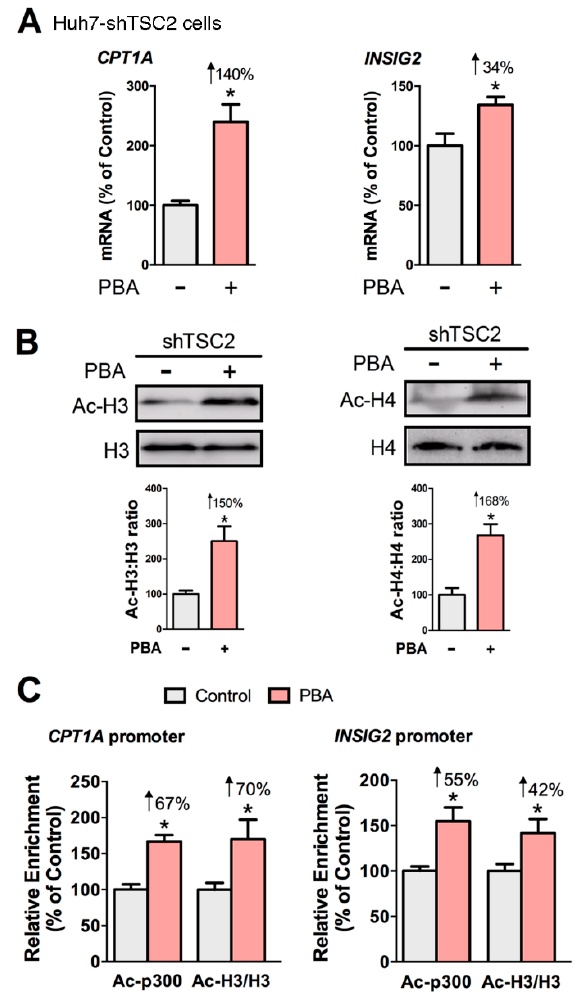
Figure 4. PBA enhances the acetylation of CBP / p300 and histone H3 at the CPT1A and INSIG2 promoters in Huh7-shTSC2 cells. PBA (8 mM, 6 h) induced the gene expression of CPT1A and INSIG2 ( A ), and the acetylation status of histone H3 and histone H4 ( B ). Chromatin immunoprecipitation (ChIP) assay revealed PBA-mediated enrichment of acetyl CBP / p300 (Ac-p300) and acetyl histone H3 (Ac-H3) at the CPT1A and INSIG2 promoters ( C ). Statistical significance was determined using Student’s t -test, * p < 0.05, n = 4.